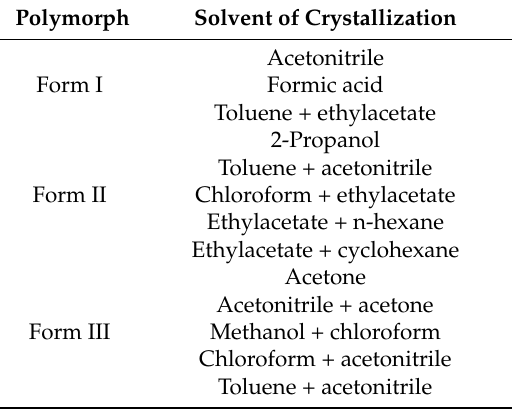
Table 1. Results of various solution crystallization